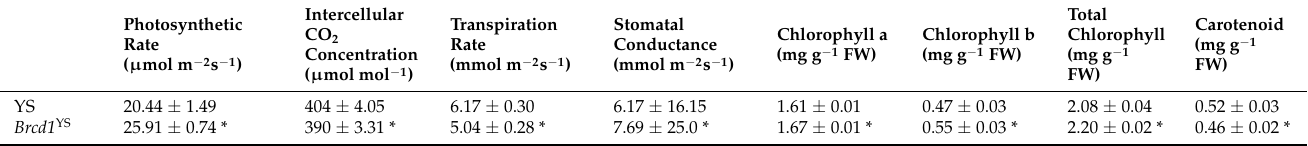
Figure 3. Evaluation of the roots of Brcd1 YS and YS. Images of the roots of Brcd1 YS and YS. ( A ): YS, ( B ): Brcd1 YS . Scale bars = 1 mm. Table 1. Evaluation of the physiological indices of YS and Brcd1 YS